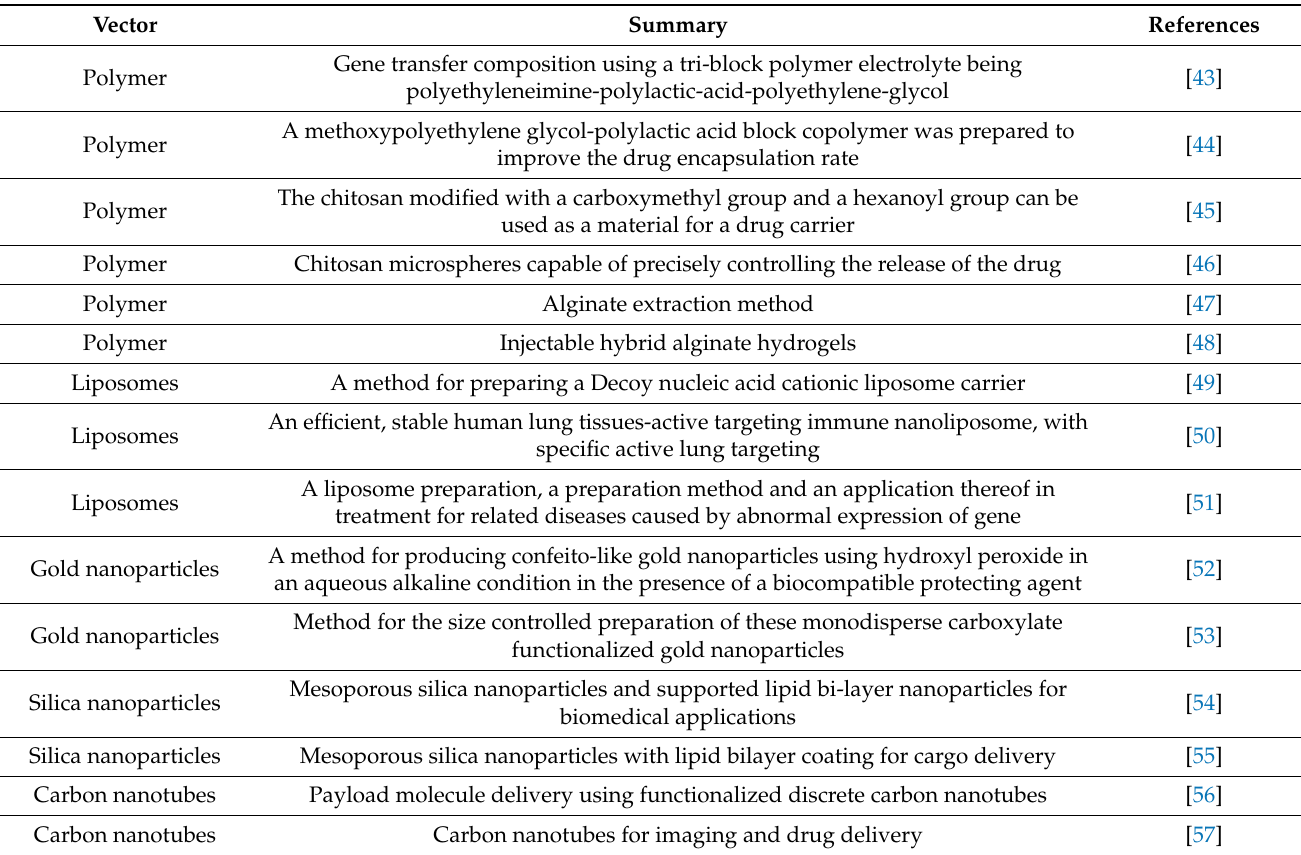
Table 2. The patent reports related to non-viral vectors in recent